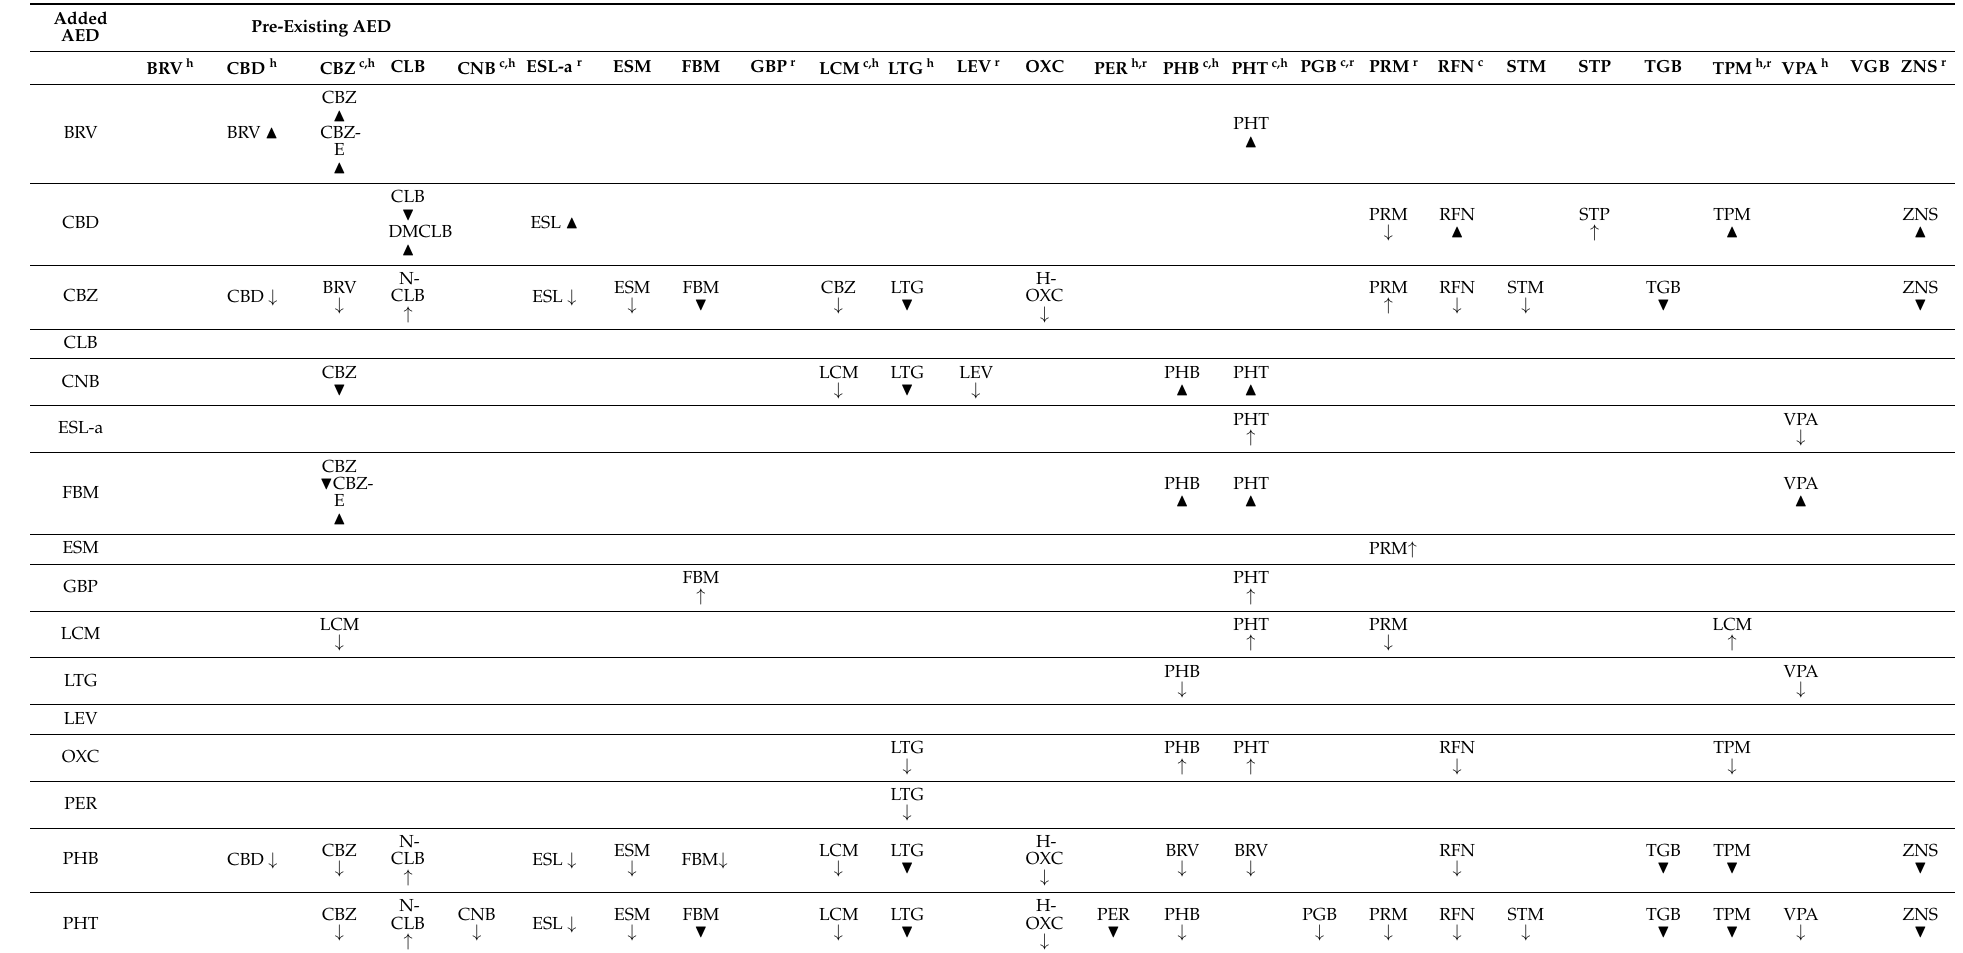
Table 2. Changes in plasma concentrations expected when an antiepileptic drug (AED) is added to a pre-existing AED regimen. Added